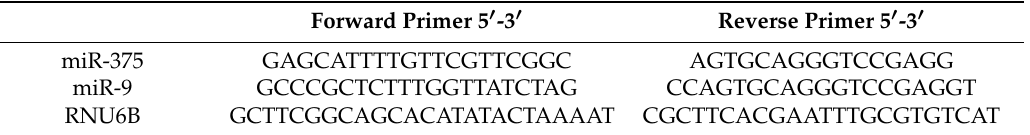
Table 1. Sequences of primers of miRNAs used